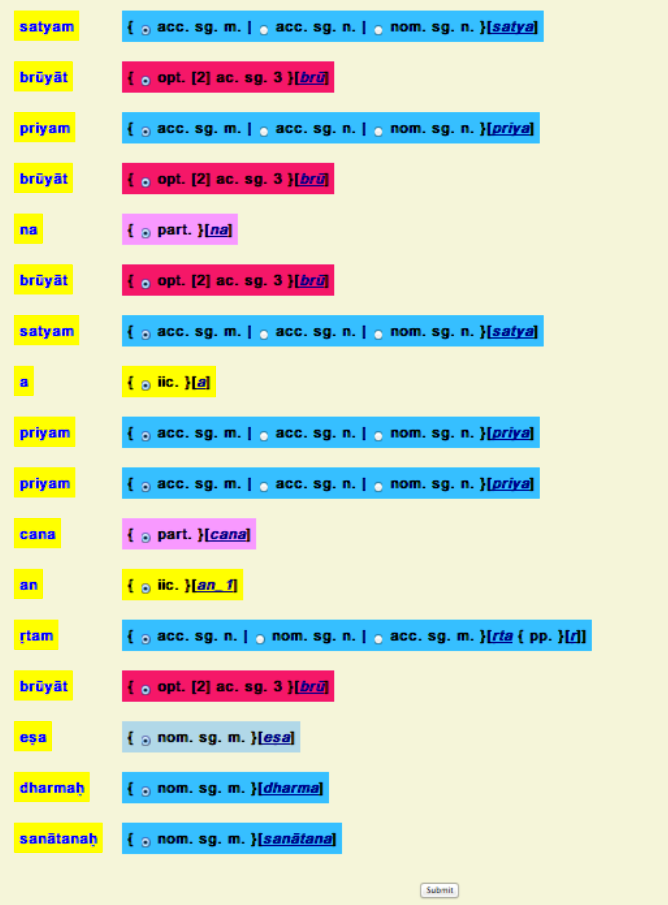
Figure 4: The interface for selecting unique tags from multi-tags